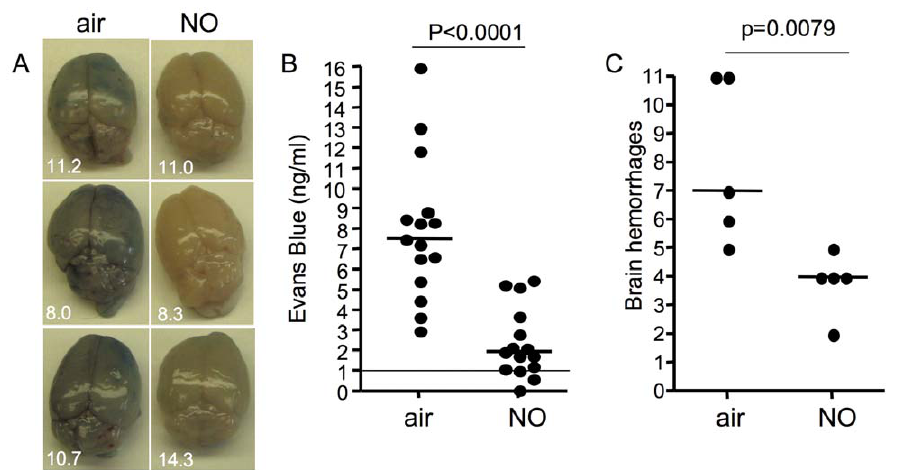
Figure 5. Inhaled NO prevents loss of blood-brain barrier vascular integrity in mice infected with P.berghei ANKA. (A) Photographs of brains from mice injected with Evans blue on day 6 post-infection. Brains from mice prophylactically treated with air (left panels) and with 80 ppm NO (right panels). The number on the lower left corner is the peripheral parasitemia for that mouse. (B) Quantification of total Evans blue extravasation in the brain as an indication of vascular leak. The line indicates median Evans blue values from uninfected mice. p , 0.0001 by Mann-Whitney. n=15 per group. (C) Number of hemorrhages quantified (blinded to the treatment group) from H&E stained sections of brains collected on day 6 post-infection from mice prophylactically treated with either air or 80 ppm NO. p=0.0079 by Mann Whitney. n=5 per group.